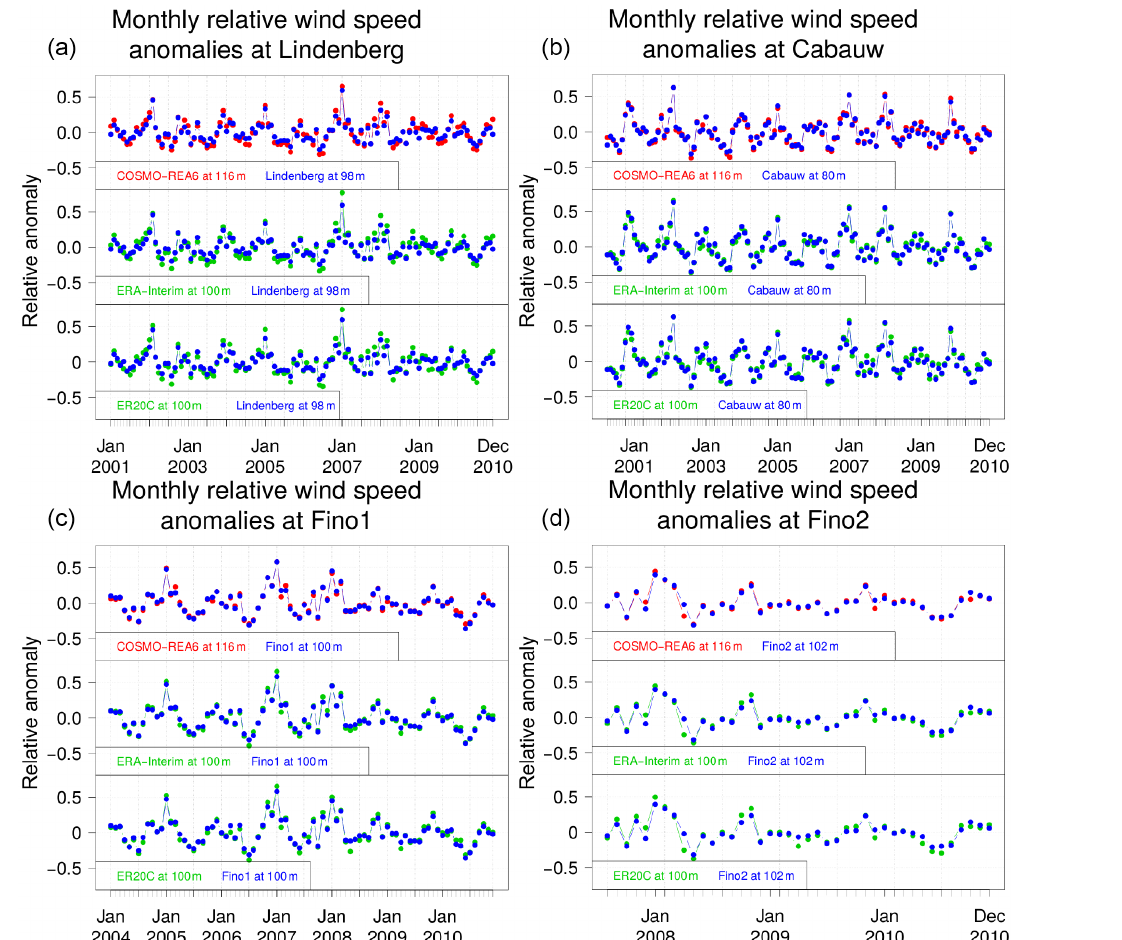
Figure 4. Same as Fig. 3 for Lindenberg (top left), Cabauw (top right), FINO1 (bottom left), and FINO2 (bottom right) at around 100m